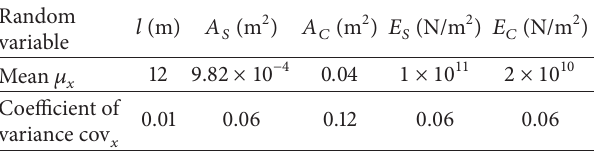
Table2:Thedistributionalparametersofthebasicrandomvariables of roof truss.